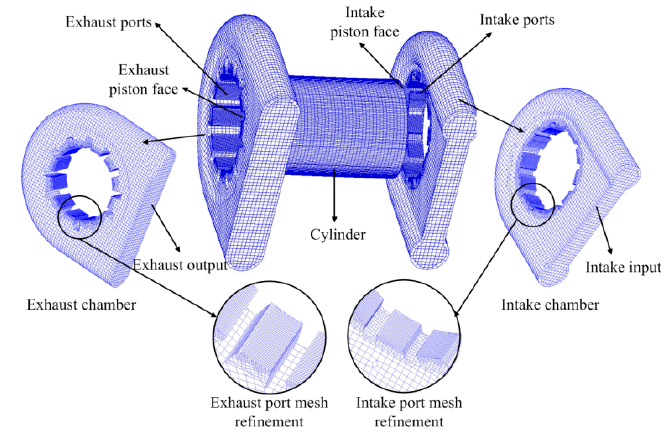
Figure 4. CFD calculation model.